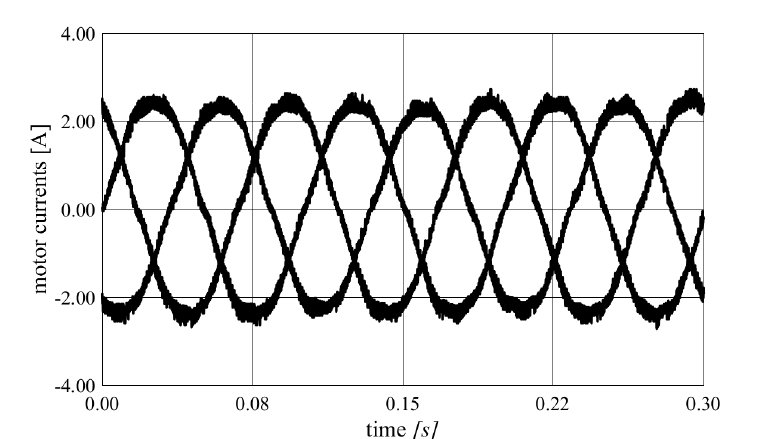
Figure 13. Experimental result: motor currents achieved with the proposed SVM based on Equation (22), when m = 0.27, v ∗ = v ∗ = 200 V, and T l = 3.5 Nm. C1 C2